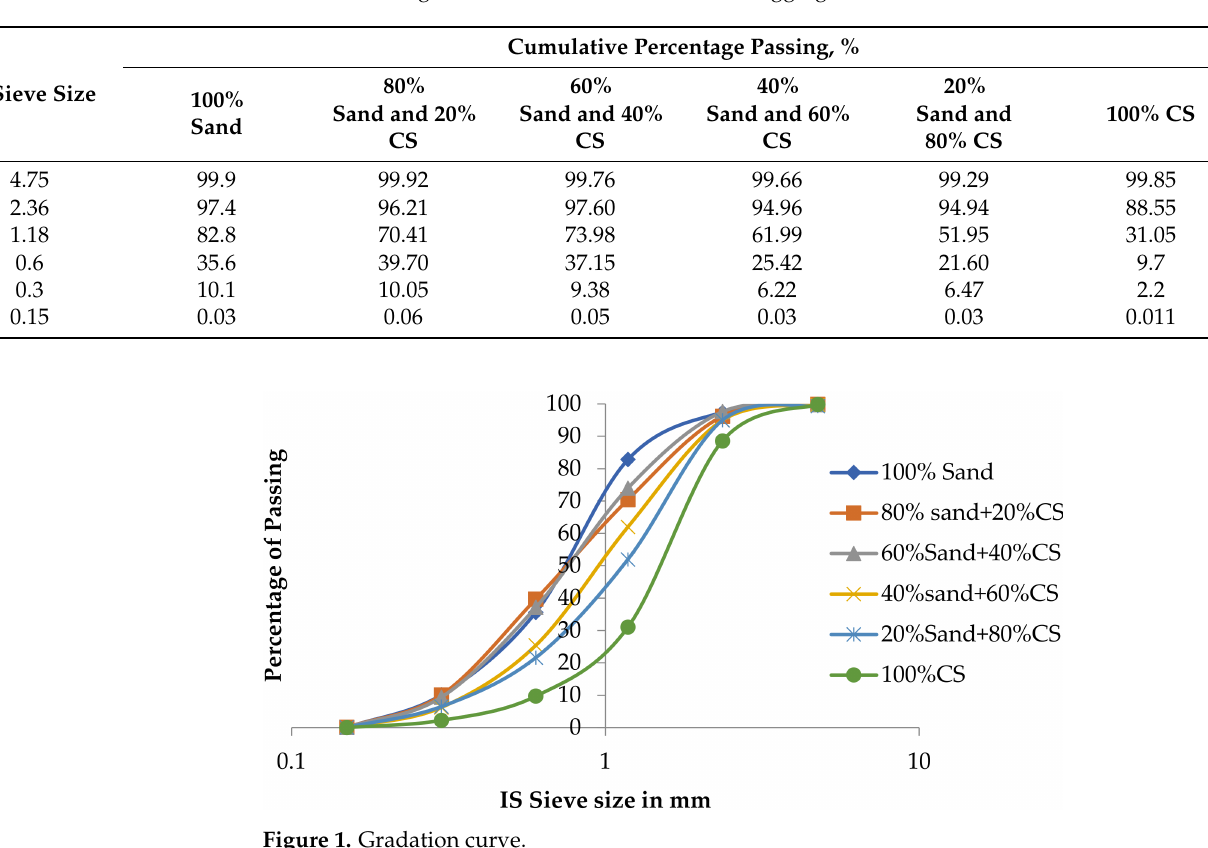
Table 3. Grading of different combinations of fine aggregate and CS.